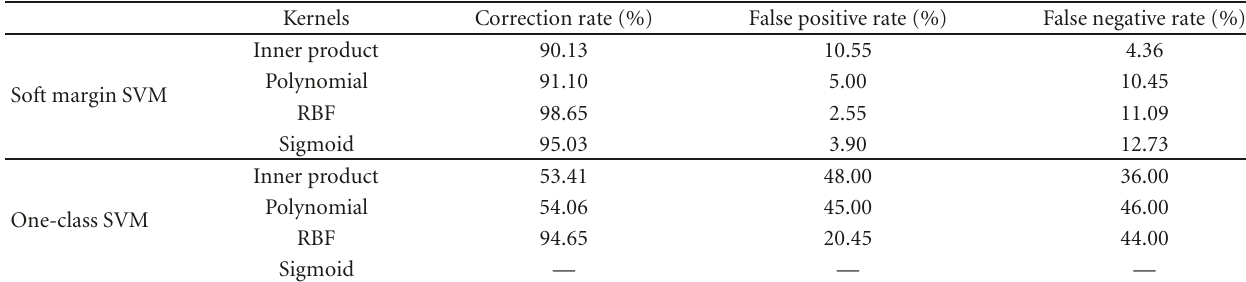
Table 4: The overall experiment results of SVMs.